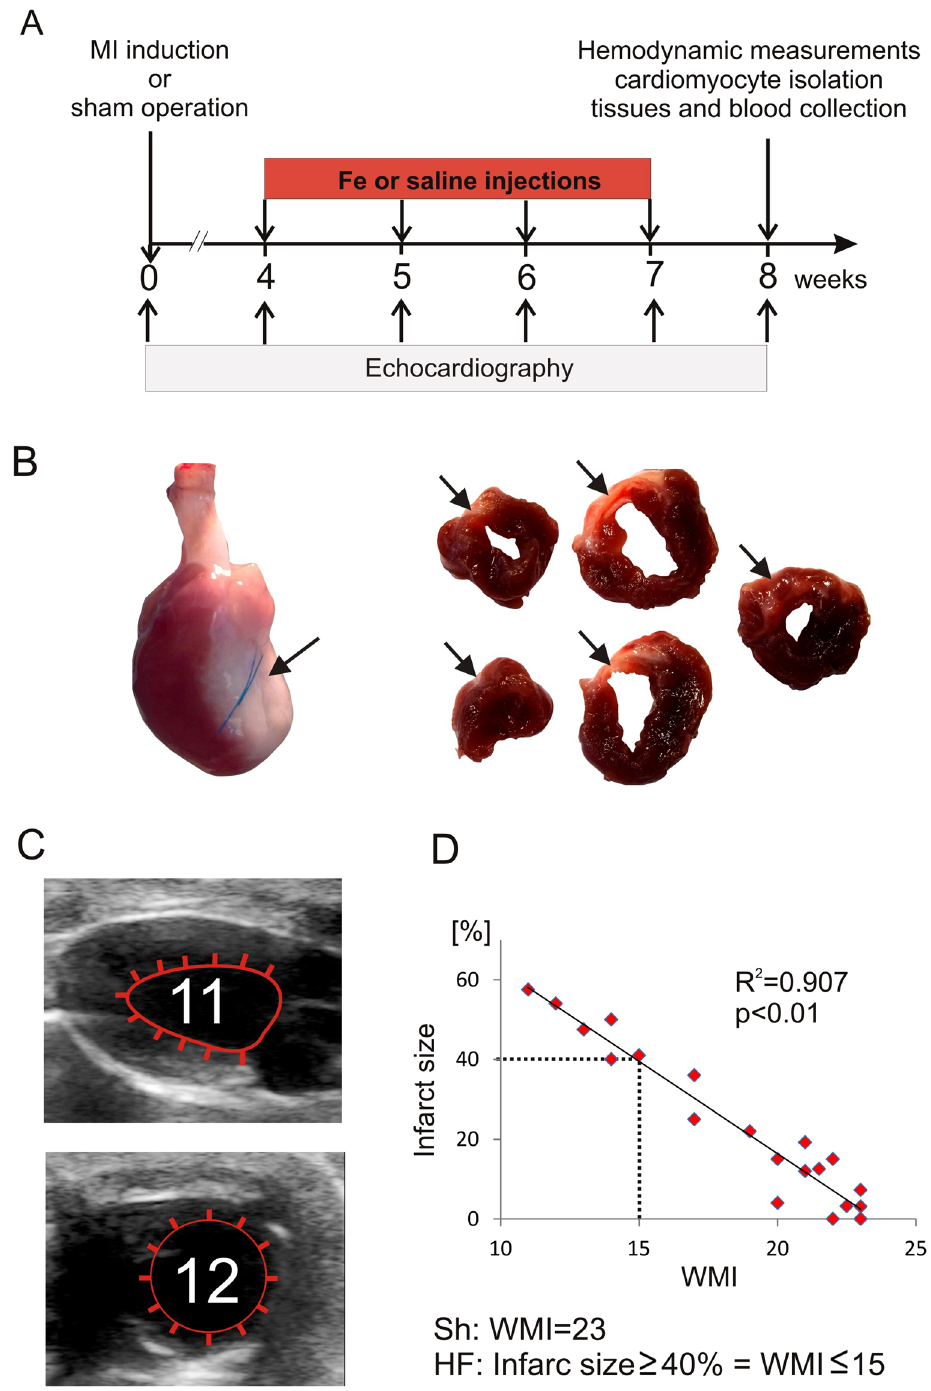
Figure 1. Experimental protocol and the myocardial infarction size evaluation by echocardiography. ( A ) Schematic representation of experimental protocol. The time of surgery, Fe or saline injections and echocardiographic examinations were indicated. ( B ) A representative heart 4 weeks after induction of myocardial infarction with visible collagen scar in LV free wall and in LV cross-sections (arrows); ( C ) the echocardiographic LV visualization in the long- (upper panel) and midpapillary short- (lower panel) axis view. Regional LV wall motion abnormalities were quantitated separately for 23 LV wall segments (11 and 12 segments visualized in the long- and short-axis view, respectively) and were graded as 1 point (normal) or 0 points (abnormal). The total WMI was calculated as a sum of the points. ( D ) WMI correlation with infarct size expressed as a percentage (calculated by dividing the sum of infarct areas from all sections by the sum of LV areas from all sections, including those with infarct scar, and multiplying by 100). WMI = 15 corresponded to infarct size